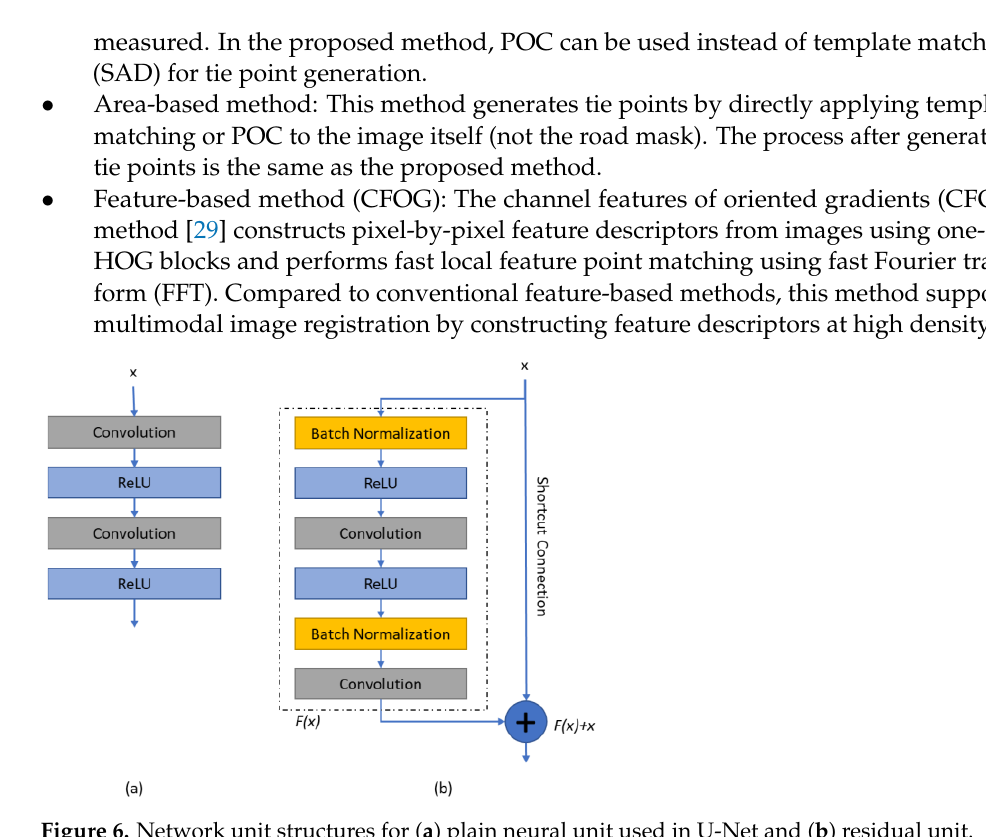
Figure 6. Network unit structures for (a) plain neural unit used in U-Net and (b) residual